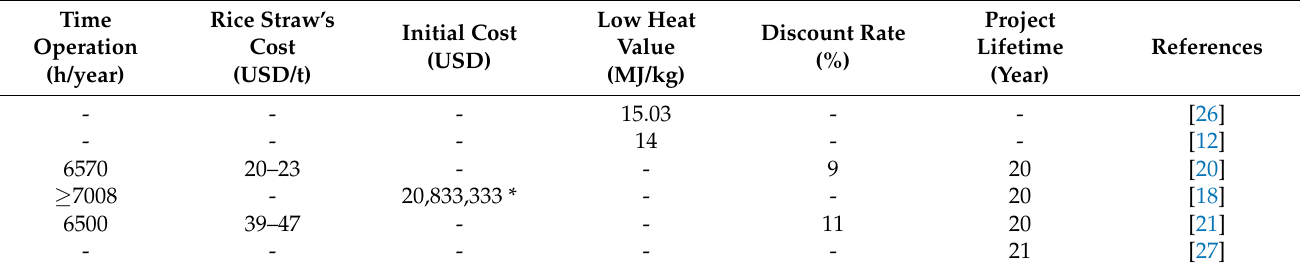
Table 5. Corresponding parameters from previous studies.